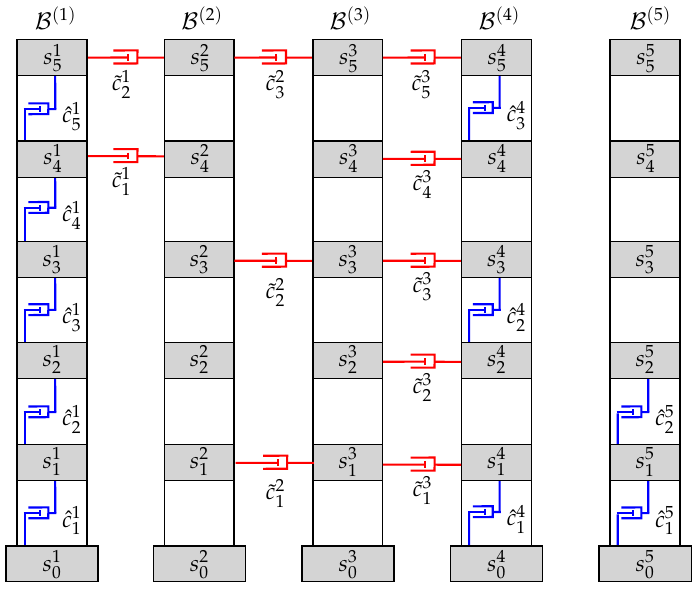
Figure 1. System of m = 5 adjacent buildings equipped with a distributed set of interstory and interbuilding